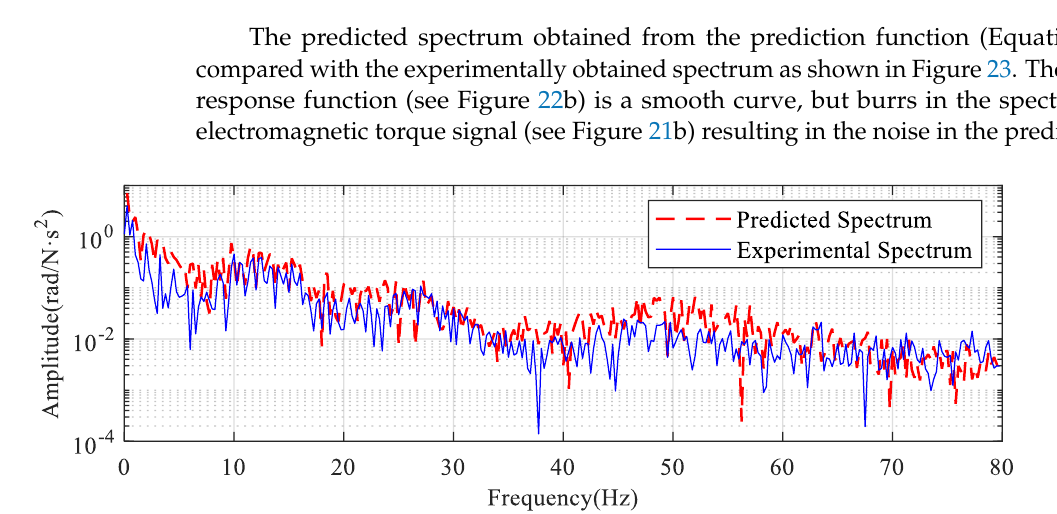
Figure 22. System amplitude and frequency characteristics. ( a ) Two dual inertia systems; ( b ) The results of the parallel connection of two dual inertia systems.